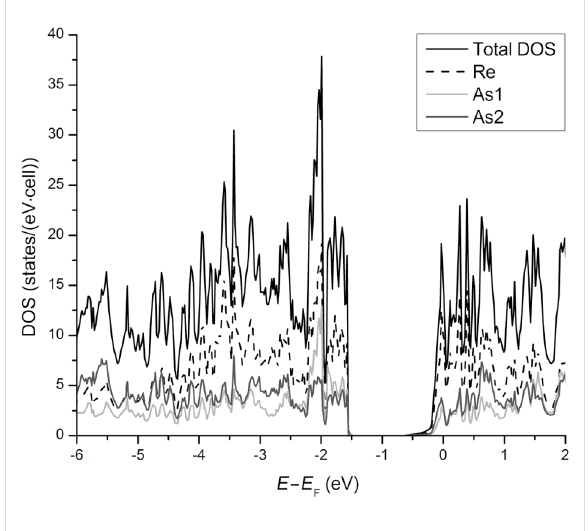
Figure 5: Density-of-states curve for Re 3 As 7 . Re contribution: dashed line, As1 and As2: light and dark gray lines, respectively.